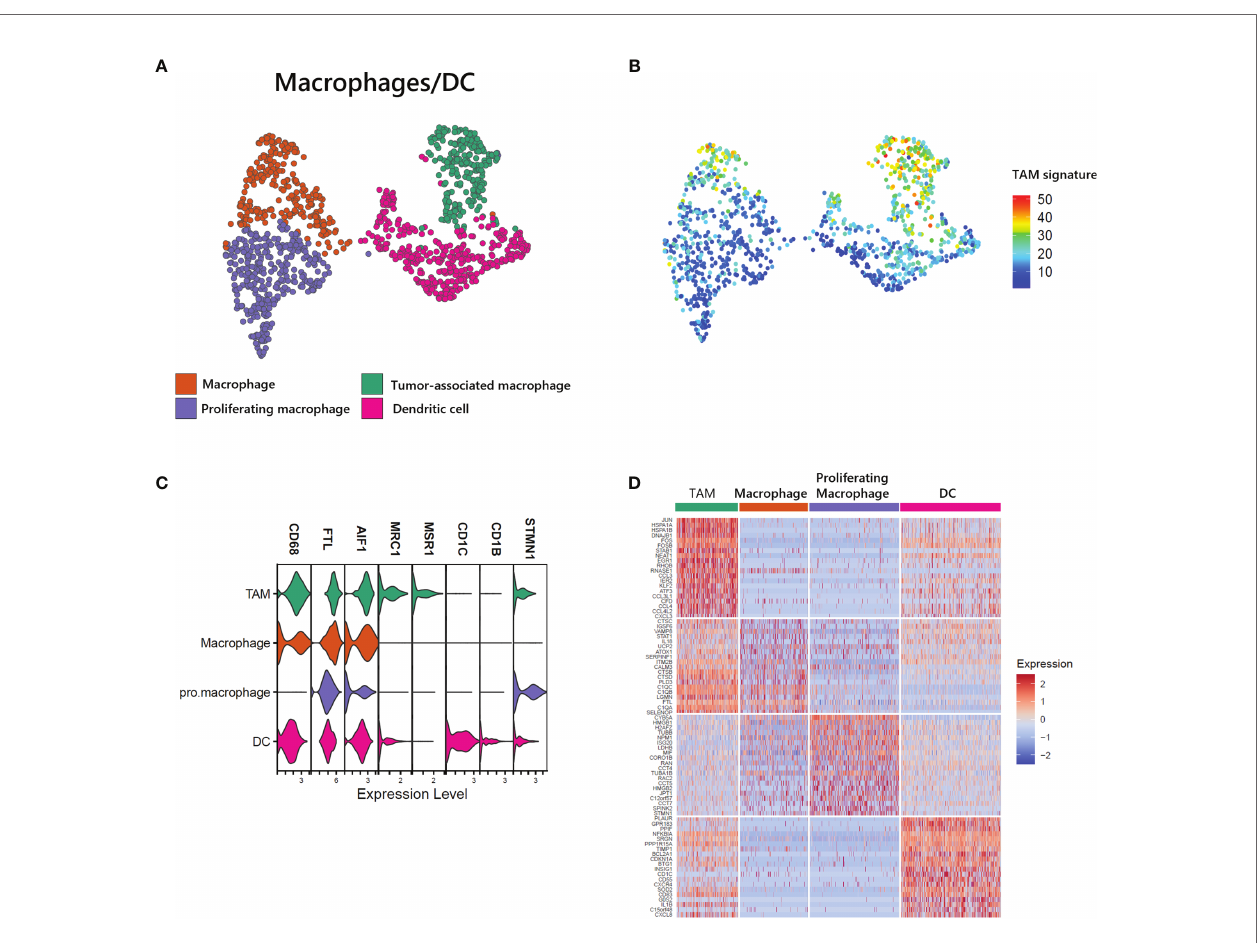
FIGURE 5 | Identi fi cation of tumor-associated macrophages (TAMs) in ATLL (A) Subtypes of myeloid cells (B) TAM score calculated with the gene set suggested by Bagaev (17) within myeloid cells (C) Cell-type markers of myeloid cells (D) Top DEGs of myeloid cell